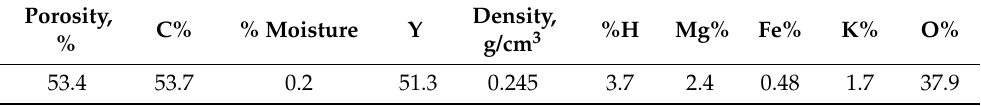
Table 1. Surface-structural properties of the AFAC.